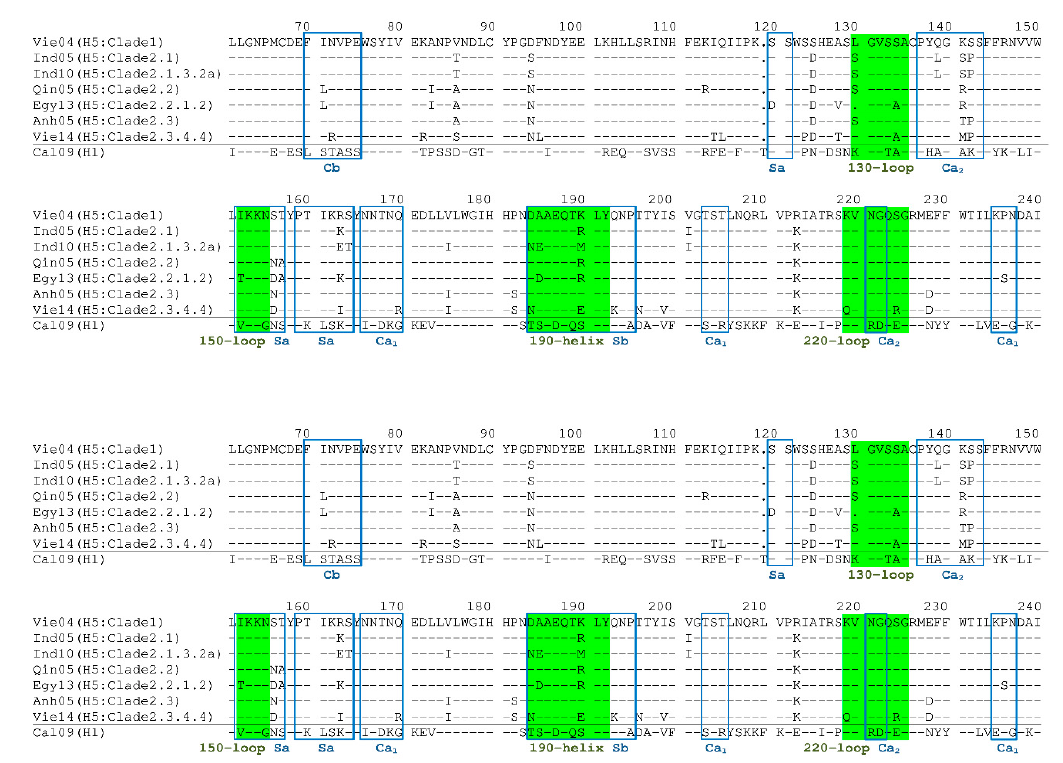
Figure 9. Amino acid sequences of antigenic sites on HAs of H5 and H1 strains used in this study. The sequence of the H5N1 Vie04 strain was used as the standard for comparison. The bars indicate identity to the amino acid in the standard. Amino acid sequences in sites Ca1, Ca2, Cb, Sa, and Sb are boxed in blue. Amino acid sequences in the 130-loop, 150-loop, 190-helix, and 220-loop are shaded in yellow-green. Accession numbers of amino acid sequences: EF541402 (Vie04); CY116646 (Ind05); DQ137873 (Qin05); DQ371928 (Anh05); AB621352 (Ind10); KJ522737 (Egy13); AB979487 (Vie14); FJ966974 (Cal09).